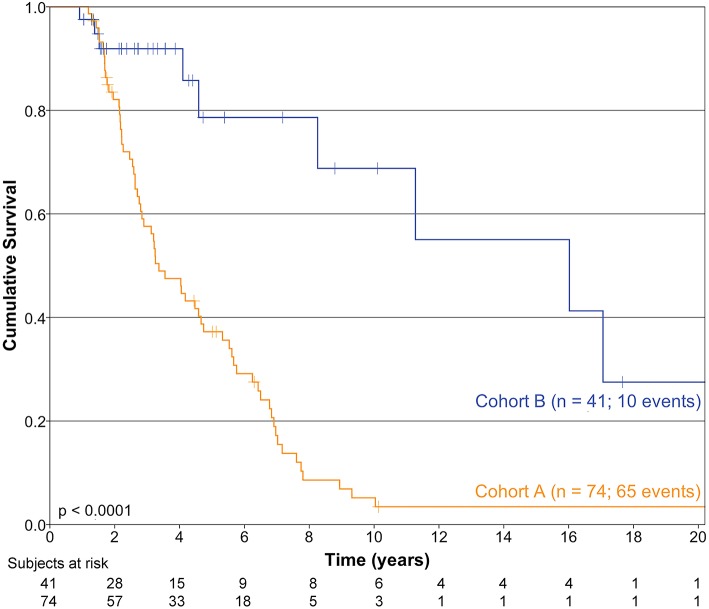
Kaplan-Meier curves depicting disease-free survival in cohorts A and B.